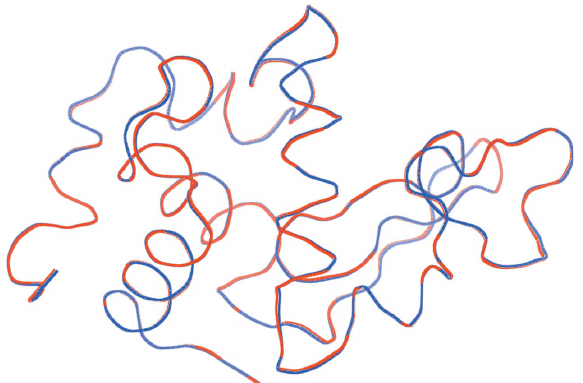
Figure 7 Superposition of the ribbon representations of the backbone chains of our structure solution (blue) and the structure of 5uvj (red) solved by Martin-Garcia et al. (2017), showing insignificant differences in structure. The C (cid:4) atoms between the two structures have an r.m.s.d. of 0.131 A˚ . Deviations greater than this occur mostly in the solvent-exposed regions, with a maximum deviation of 0.337 A˚ , though the deviations are only apparent by occasional changes in color from red to blue along the backbone.